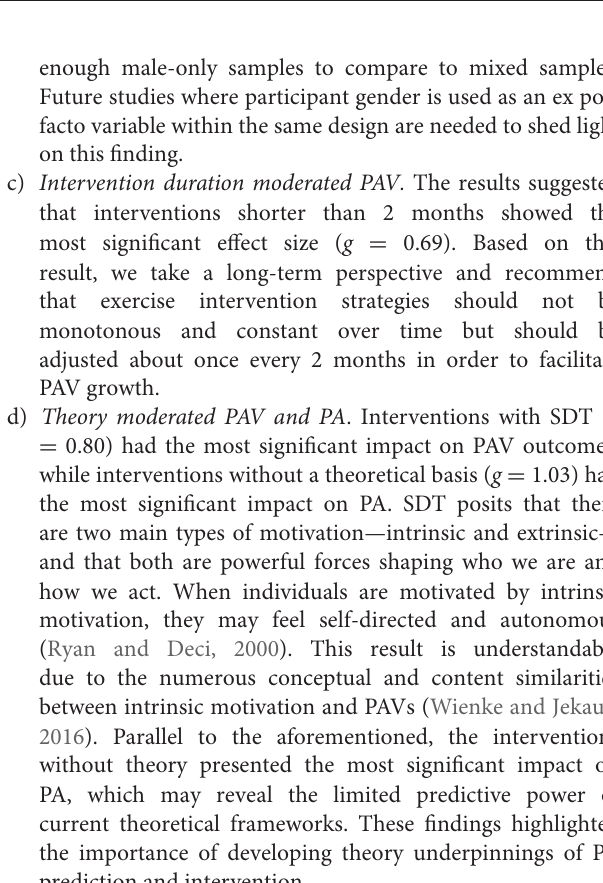
FIGURE 3 | Funnel plot of physical activity in this